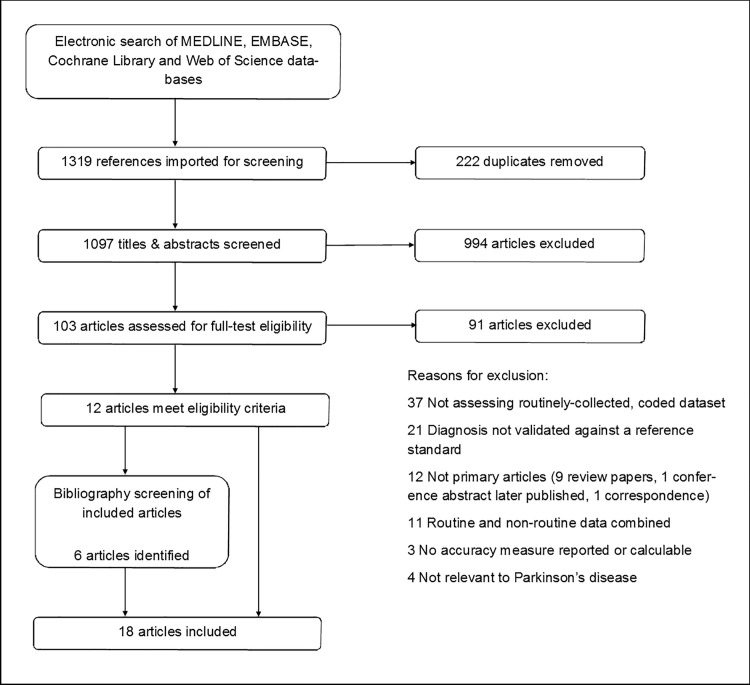
PRISMA flow diagram.